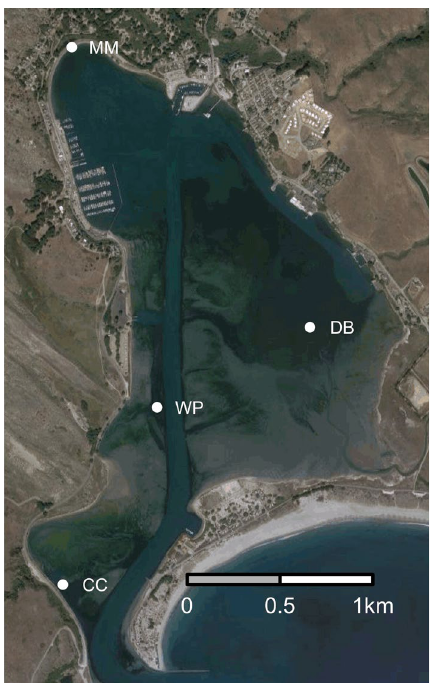
package “ggmap”. 74